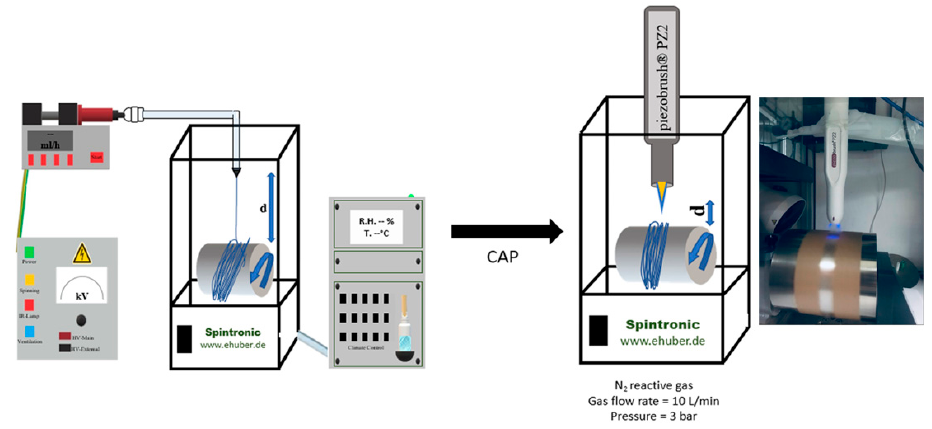
Figure 1. Experimental design of electrospun PLGA microfibers fabrication and Cold Atmospheric Plasma (CAP) performance. (“d” is the distance between the needle and the collector in the electrospinning process machine (left) and the distance between the plasma handled device and the collector during the plasma treatment process (right)).